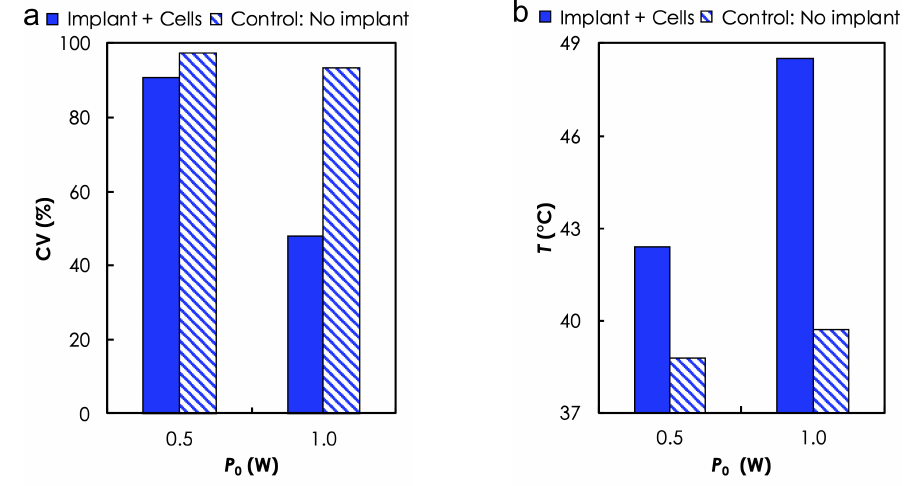
Figure 5. Photothermal heating in cell suspensions results. ( a ) In vitro cell viability assessed with Trypan blue dye and ( b ) the corresponding temperature change as a function of laser power after 5 min of